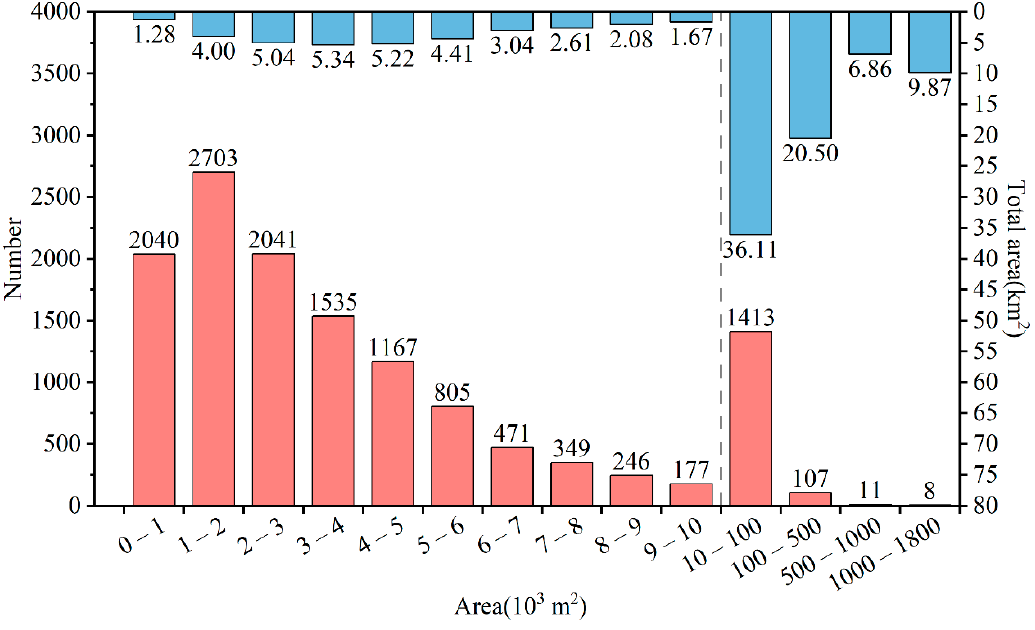
Figure 9. Number (red) and total area (blue) of ponds after post-classification improvement under different area levels of Beijing in 2018/2019.